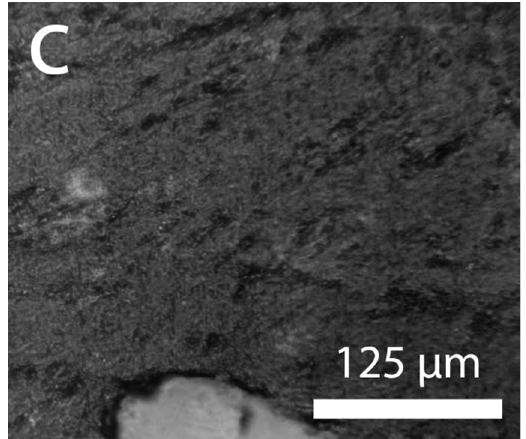
Figure 10. Optical microphotographs of polymer binder surface ( a ) and composites with wheat straw and filler content: ( b )—30 wt.%; ( c )—50 wt.%.